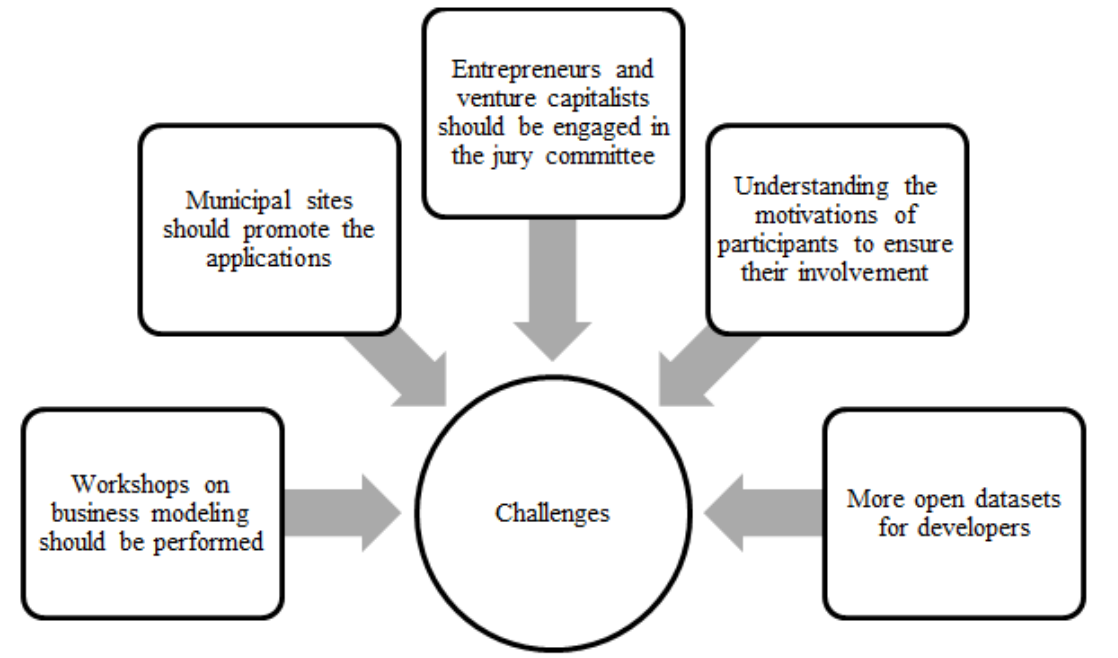
Figure 4. Challenges in Thessaloniki’s digital contests.